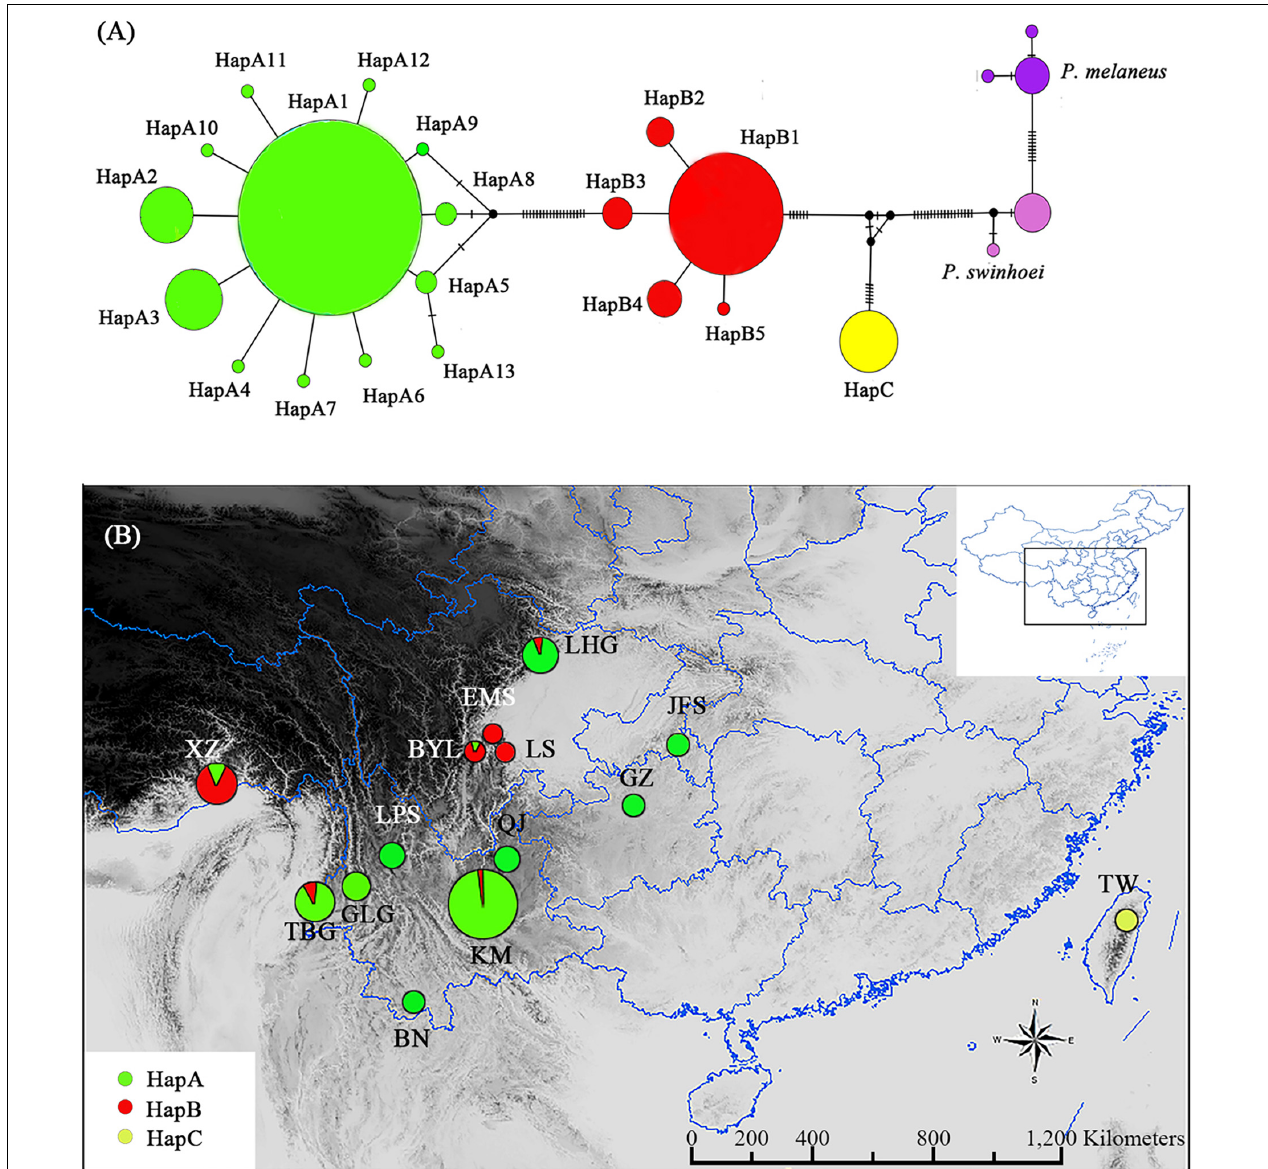
FIGURE 1 | Parantica sita haplotypes based on cytochrome oxidase subunit I (COI) sequencing. (A) Haplotype network diagram of the 19 sampled populations. Circle size is proportional to the numbers of samples and each vertical line between haplotypes indicates a base difference. (B) The geographical distributions of the three haplotype groups. Circle size is proportional to the number of samples. XZ: Motuo, Tibet; TBG: Tongbiguan, Yunnan; GLG: Mt. Gaoligong, Yunnan; LPS: Mt. Luoping, Yunnan; BN: Xishuangbanna, Yunnan; KM: Kunming, Yunnan; QJ: Qujing, Yunnan; BYL: Bayuelin Nature Reserve, Sichuan; EMS: Mt. E’mei, Sichuan; LS: Leshan, Sichuan; LHG: Laohegou Nature Reserve, Sichuan; JFS: Mt. Jinfo, Chongqing; GZ: Guizhou; TW: Mt. Yangming, Taiwan. The inset shows the distribution area within